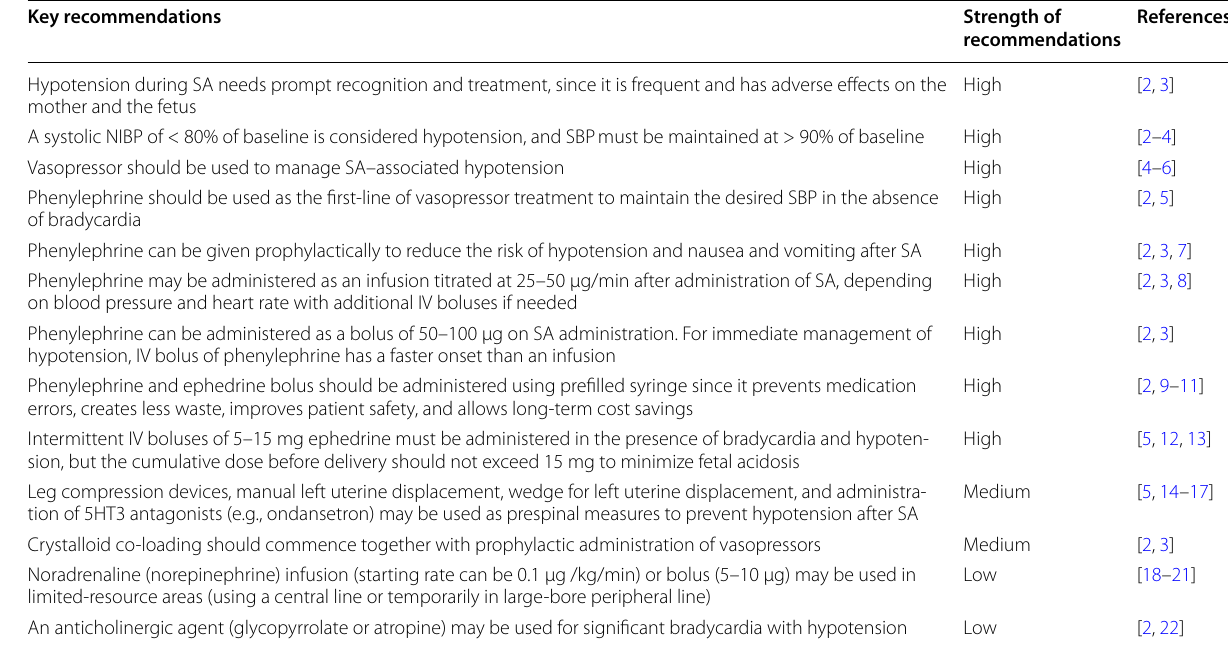
Table 1 Key recommendations for best clinical